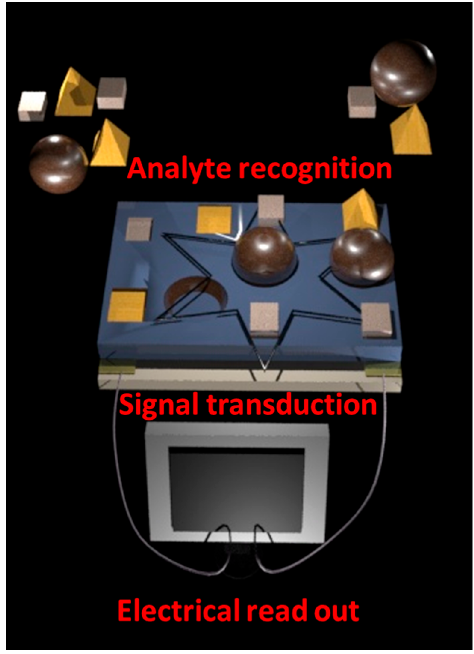
Figure 12. Schematic illustration of an electrochemical sensor consisting of substrate, electrodes, and CP film which is acting as sensing material and transducer. The overall sensing process involves analyte recognition, signal transduction, and electrical readout.